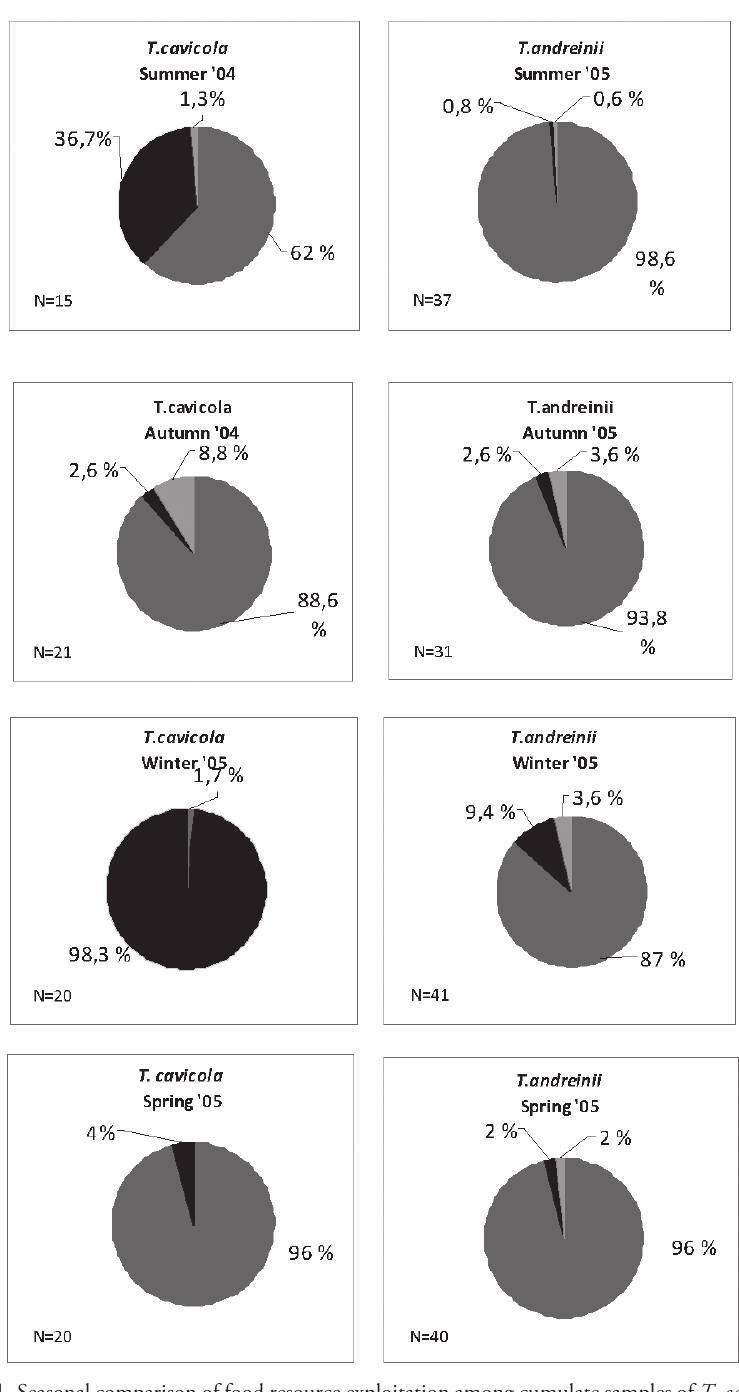
Figure 1. Seasonal comparison of food resource exploitation among cumulate samples of T. cavicola and T. andreinii . Grey: green vegetables; light grey: fibres; black: arthropod